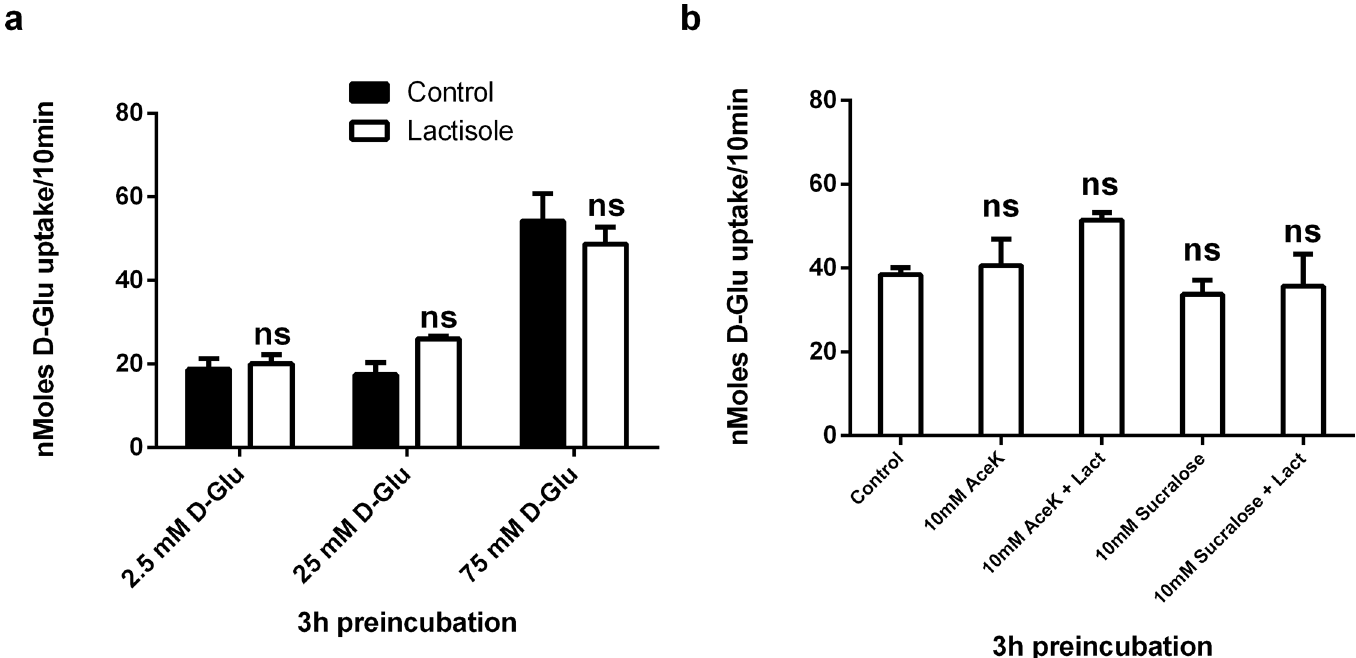
Fig 4. Acute effects of the sweet taste inhibitor, lactisole and artificial sweetenerson carrier mediated glucose transport in Caco-2/TC7 cells. (a) Caco-2/TC7 cells grown for 21 days were incubatedwith 2.5, 25 and 75 mM D-Glucosefor 3hrs in the presenceor absenceof 0.5 mM lactisole,washedthree times with glucose free KBS, followedby 10 min exposureto [ 14 C] 10 mM D-Glucose. Osmolarity was adjustedby addingMannitol.(b) Cells were incubated with 75 mM D-Glucosein the presenceof 10 mM AcesulfameK(AceK) or Sucralosewith the additionof lactisoleat 0.5mM. Osmolarity was adjusted for by addingMannitol.Cellularuptake of D-Glucosewas measuredby radioactive scintillation spectrometry. Uptake is corrected for simple diffusionof 10 mM [ 14 C] L-Glucose.Data are expressedas nMoles D-Glucoseuptake/well/10min ± SD of n = 4 per condition. ns = not